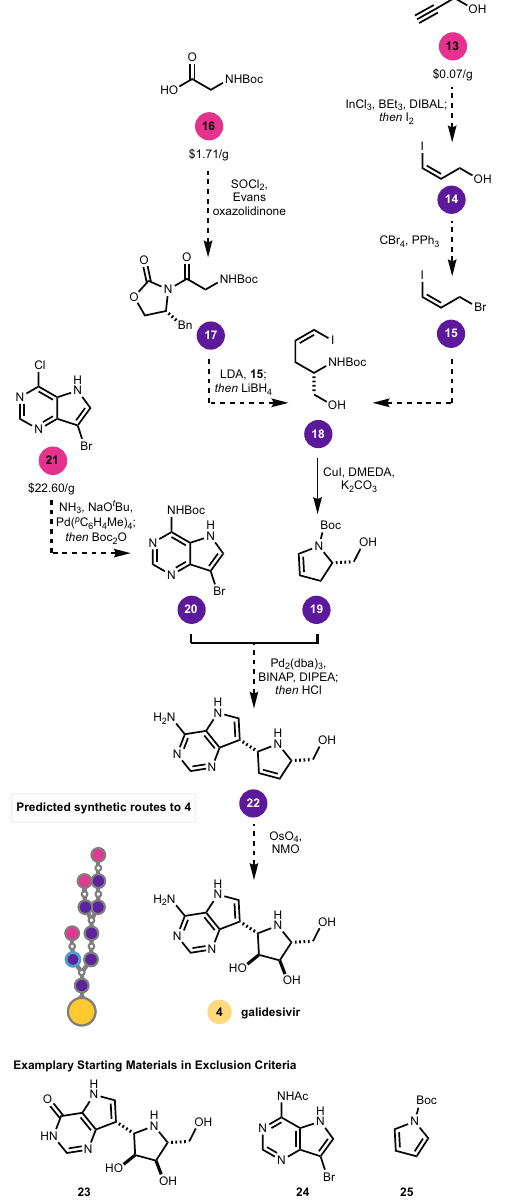
Fig. 3 Predicted synthetic sequence to 4. Reaction conditions are proposals from the SYNTHIA ™